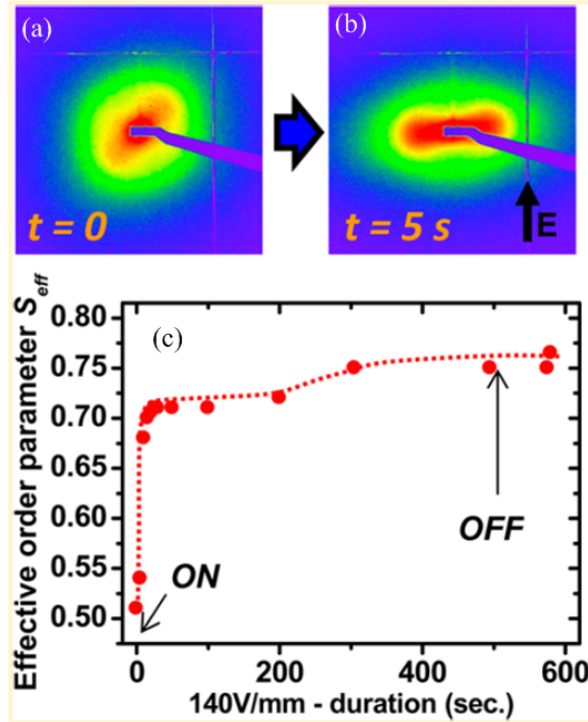
Figure 19: SAXS patterns of an anisotropic chitin nanorod- siloxane oligomers hybrid suspension in ethanol/aqueous 10 −4 M HCl 50/50 wt %, with CCHI = 5.0 wt.%, CSi = 10.7 wt% before (a) and (b) after application of an electric field as a function of time. The direction of the field with respect to the SAXS patterns is indicated by the black arrow in (b). (c) Order parameter S inferred from I = f( ψ ) traces as a function of duration of the electric field application. The two last data points were taken more than 80 s after the field was switched off. The dashed line is a guide to the eye [98]